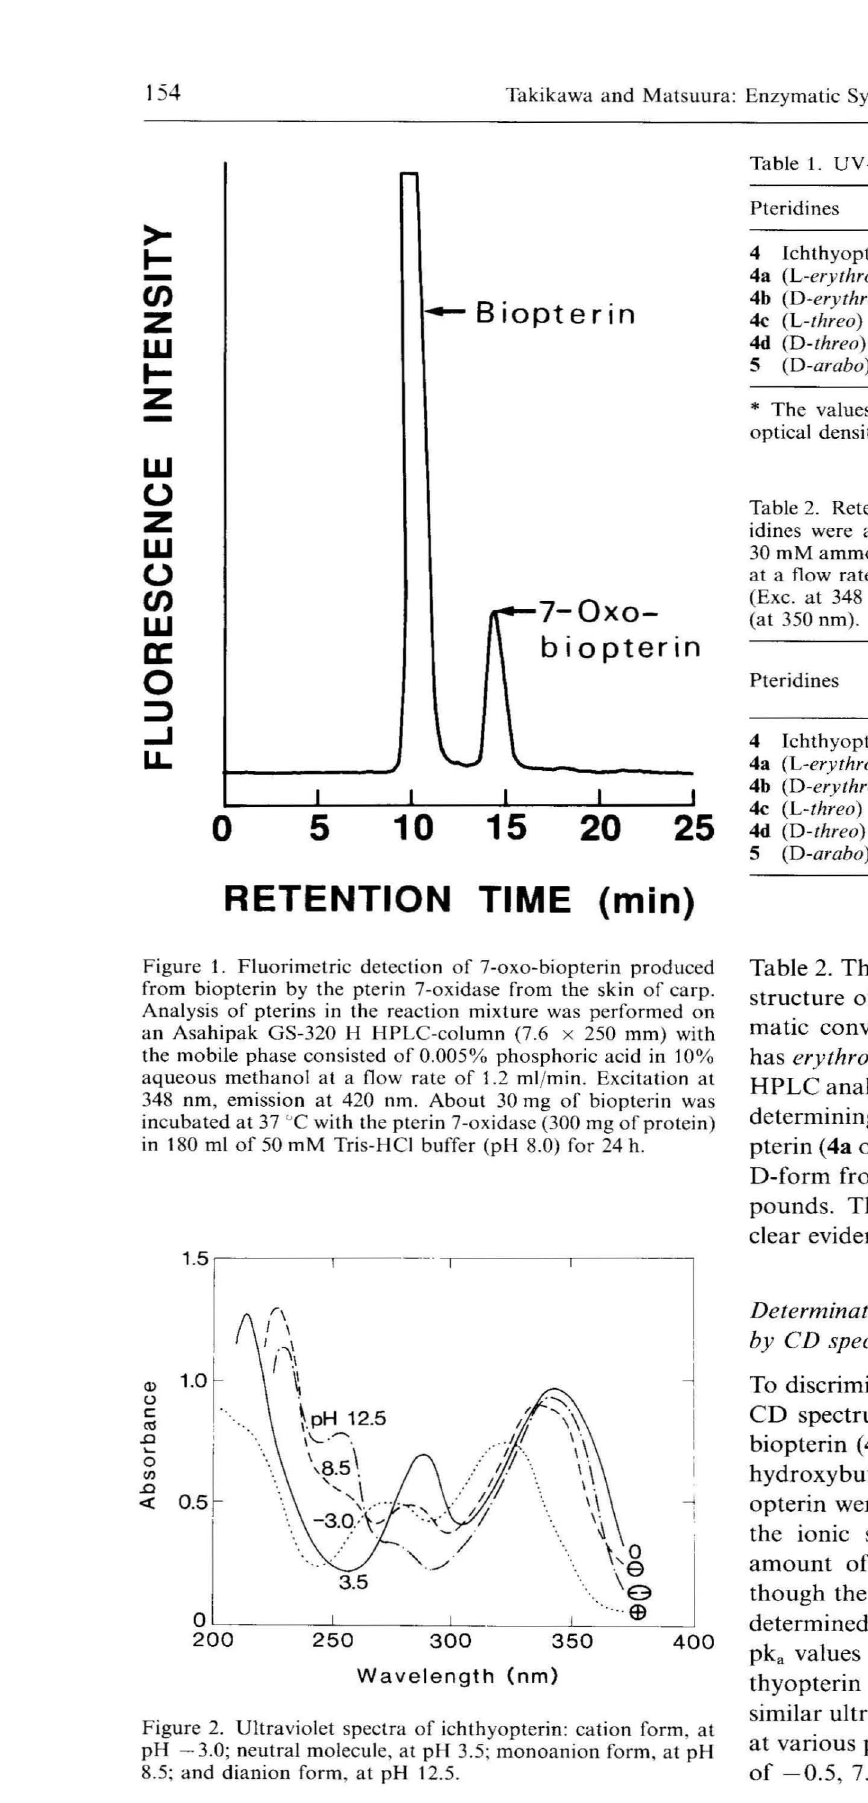
Figure 2. Ultraviolet spectra of ichthyopterin: cation form, at pH - 3.0; neutral molecule, at pH 3.5; monoanion form, at pH 8.5; and dianion form, at pH 12.5. Pteridines / Vol. 2 / No.3